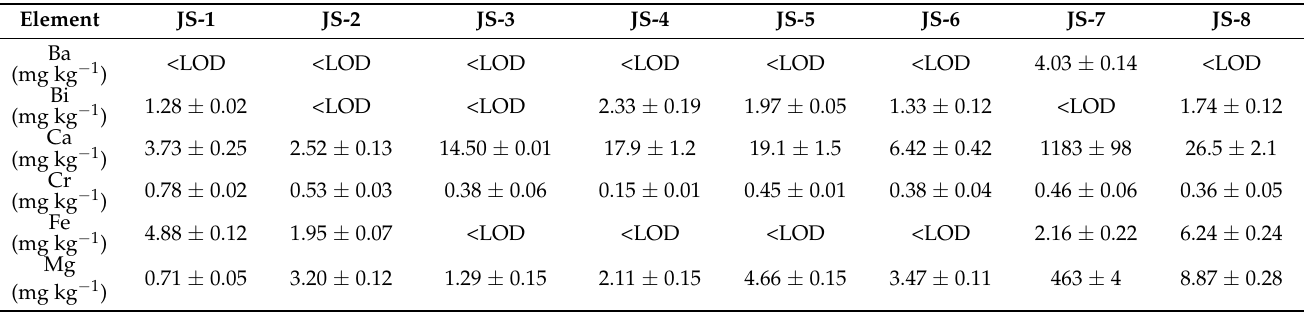
Table 6. Elemental composition of the jelly